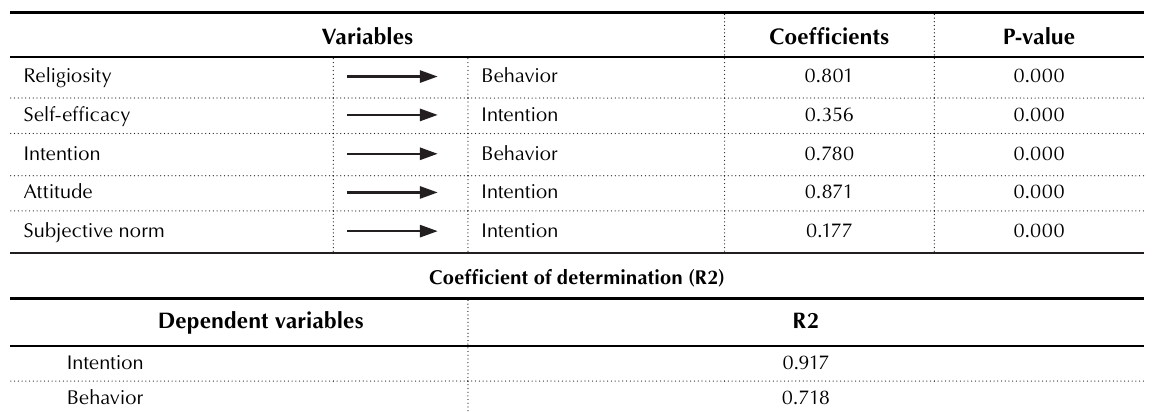
Table 3. Hypotheses test